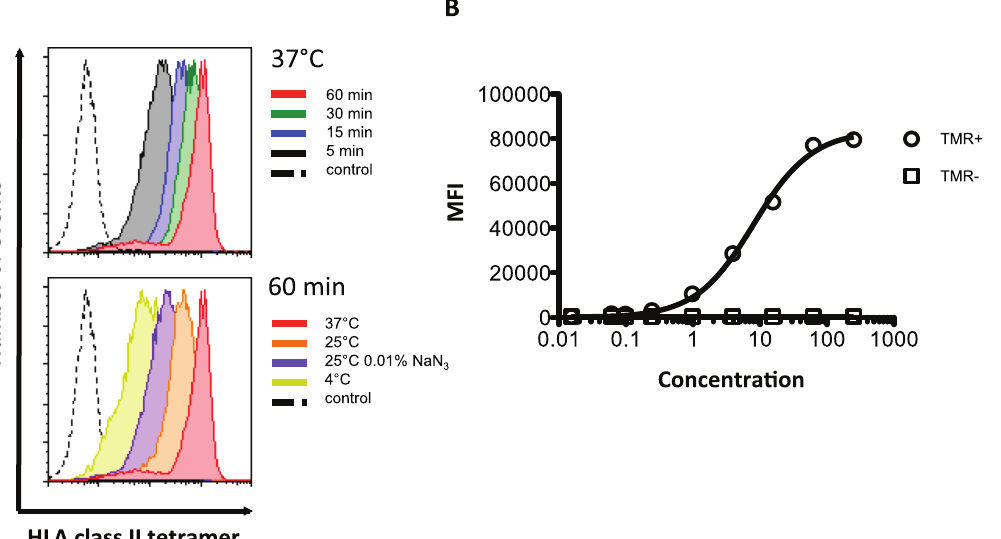
Figure 2. Optimization of time and temperature parameters and concentration of MHC class II tetramer. A) The staining optimization was performed on an HA 307–318 -specific CD4 + T cell line (approximately 100% antigen-specific) with HLA-DRB1*04:01-HA 307–318(H6) and HLA- DRB1*04:01-Hep C NS3 218–235(H6) PE-conjugated tetramers at a concentration of 12.5 nM. Top histograms illustrate staining with HLA-DRB1*04:01- HA 307–318(H6) at 37 u C with varying time intervals (black: 5 min; blue: 15 min; green: 30 min; red: 60 min). The dotted black line depicts cells stained with DRB1*04:01-Hep C NS3 218–235(H6) for 60 min at 37 u C (control). Bottom histograms illustrate staining with DRB1*04:01-HA 307–318(H6) for 60 min with varying temperature and conditions (lime: 4 u C; purple: 25 u C and exposure to 0.01% NaN 3 ; orange, 25 u C; red: 37 u C). The dotted black line illustrates cells stained with DRB1*04:01-Hep C NS3 218–235(H6) for 60 min at 37 u C (control). B ) Titration of PE-conjugated HLA-DRB1*01:01-HA 307–318(H6) tetramer. In vitro cultured PBMCs from a donor expressing HLA-DRB1*01:01 were stained with increasing MHC class II tetramer concentrations (x-axis). The mean fluorescence intensity (MFI) obtained is shown on the y-axis. Circles illustrate data points of the MHC class II tetramer-labeled CD4 + T cell